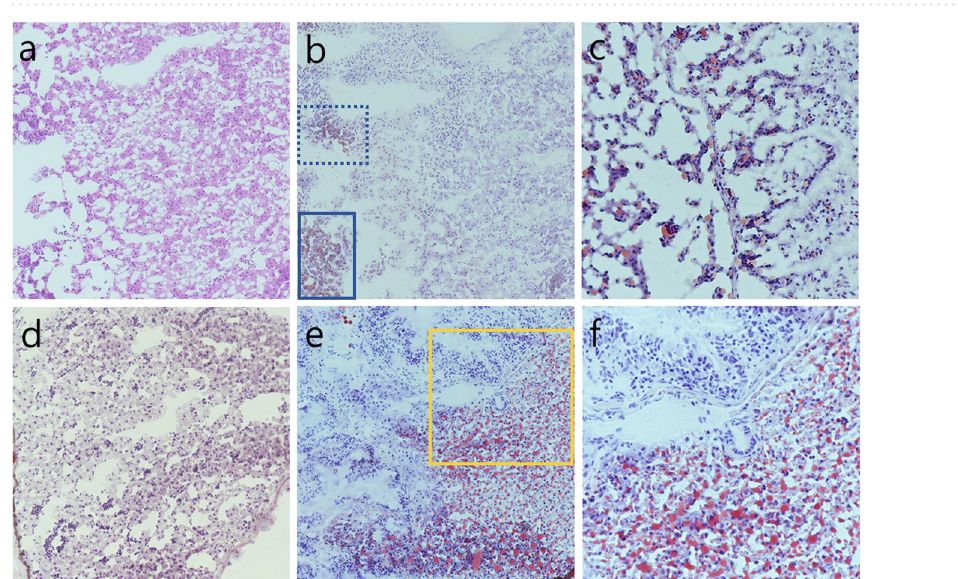
Figure 2. A representative frozen section (× 200, hematoxylin and eosin) (a) of a liver was obtained from zebrafish No. 5 (low fatty liver group) and stained with oil red O. In the same area of Fig. 1a, a 10% fatty change was observed with oil red O positive stain (box) (× 200) (b) . Higher magnification of the oil red O positive area (lower box marked with solid line in Fig. 1b) (× 400) (c) . A representative section of oil red O stain from the zebrafish before feeding a high cholesterol diet (× 200) (d) (see the workflow diagram of Fig. 1). The high fatty liver group contains zebrafish that have a proportion score of no less than 50 (× 200) (e) . At higher magnification (yellow box in Fig. 1e), both macrovesicular and microvesicular fatty changes were detected at high levels in the high fatty liver group compared to the negative internal control of the glandular epithelial cells in the stomach (left upper side) (× 400) (f)